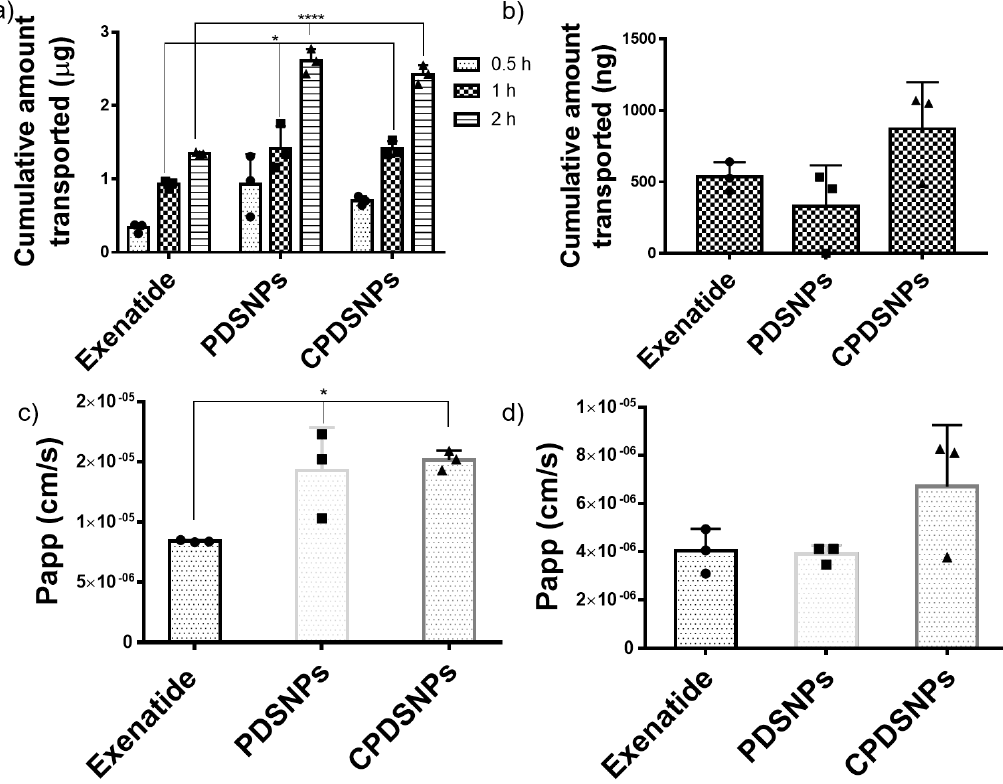
Figure 5. ( a ) Cumulative amount of exenatide transported through the Caco-2 monolayer at 0.5, 1, and 2 h, where monolayers were incubated with 40 µg/mL exenatide solution and equivalent exenatide-loaded nanoparticles (all data are n = 3, mean ± SD, and analyzed by one-way ANOVA, post-hoc Tukey’s test, * p < 0.05, **** p < 0.0001) ( b ) Cumulative amount of exenatide transported through the triple co-culture model at 2 h, where the cellular barrier was incubated with 40 µg/mL exenatide solution and equivalent exenatide-loaded nanoparticles. ( c ) Apparent permeability coefficient (Papp) of exenatide from PDSNPs and CPDSNPs at 2 h in the Caco-2 monolayer (all data are n = 3, mean ± SD, and analyzed by one-way ANOVA, post-hoc Tukey’s test, * p < 0.05). ( d ) Apparent permeability coefficient (Papp) of exenatide from PDSNPs and CPDSNPs at 2 h in the triple co-culture model (all data are n = 3, mean ±